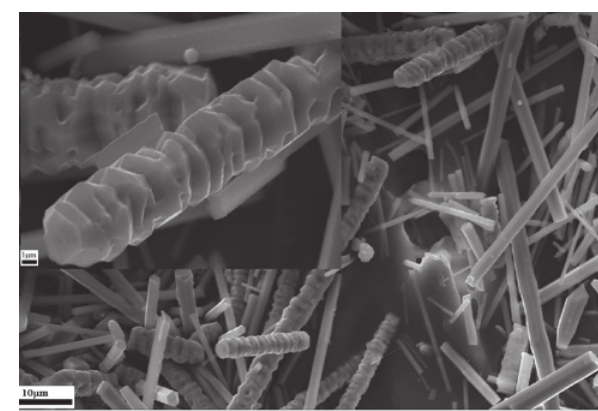
Fig. 5: SEM images of AlN whiskers with growth step at different